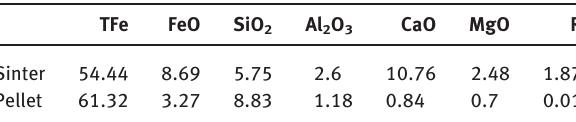
Table 1: The chemical composition of pellet and sinter (wt%) and basicity.